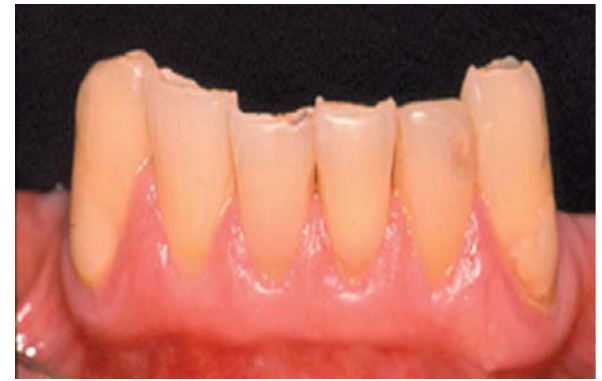
FIGURE 3- Extrusion of the mandibular anterior teeth